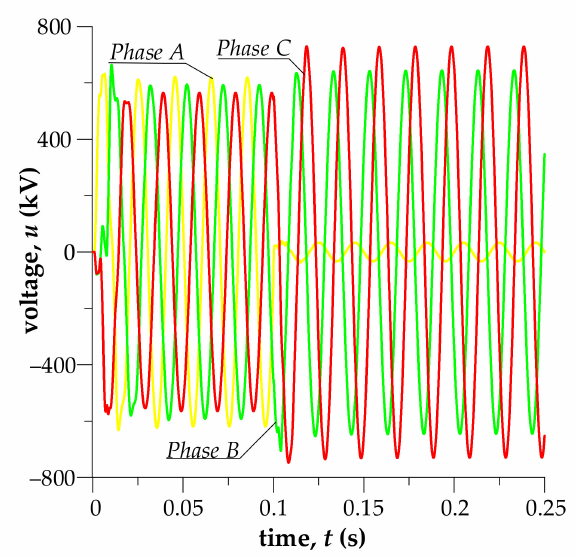
Figure 9. Transient phase voltages in the final discretisation node (18 km away from the line’s end) for the first